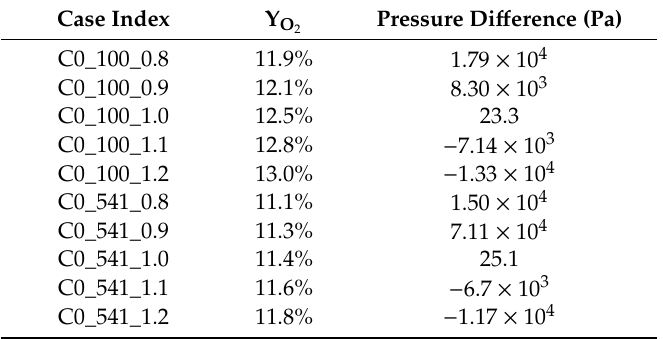
Table 3. Predicted average oxygen mass fraction and pressure di ff erence for case series